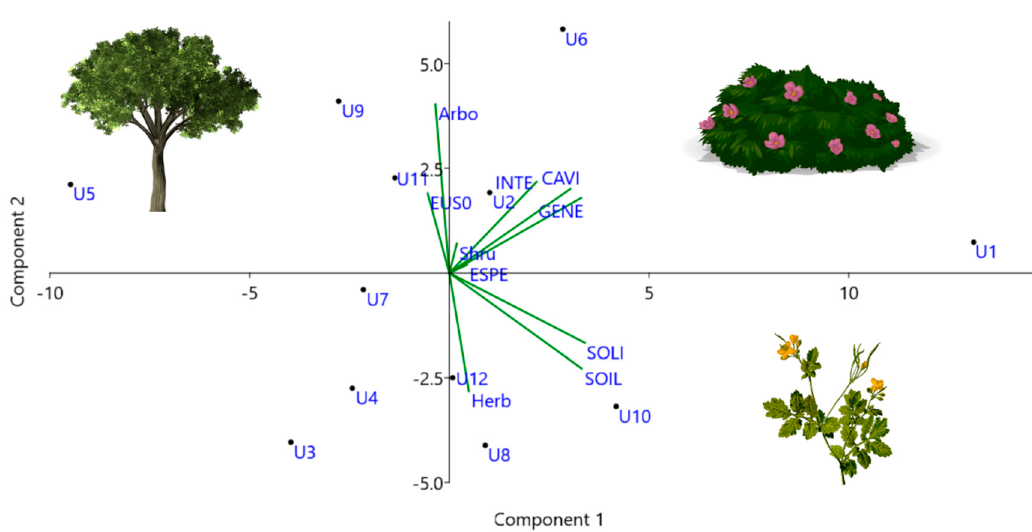
Figure 3. Principal Component Analysis (PCA) plot of correlation between bee guilds: SOIL (soil), CAVI (cavity), SPEC (specialist), GENE (generalist), SOLI (solitary), INTE (intermediate), EUSO (eusocial), and plant habits: Arbo (arboreal), Shru (shrubby) and Herb (herbaceous), U1 to U12 represent the urban green areas studied in Campos dos Goytacazes, Brazil.